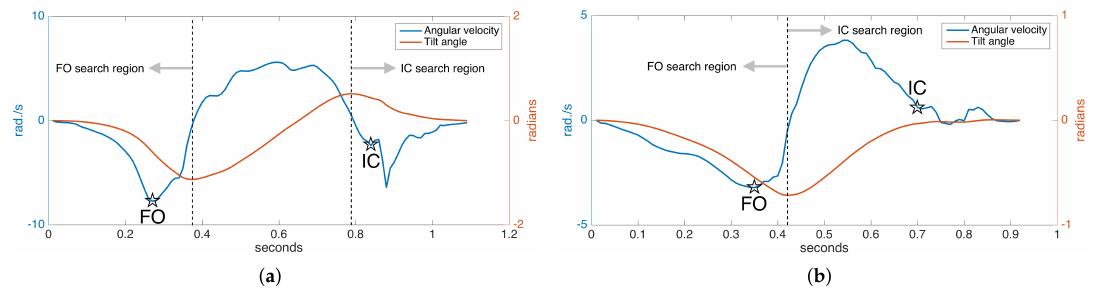
Figure 10. Detected FO and IC events: ( a ) normal gait and ( b ) pathological